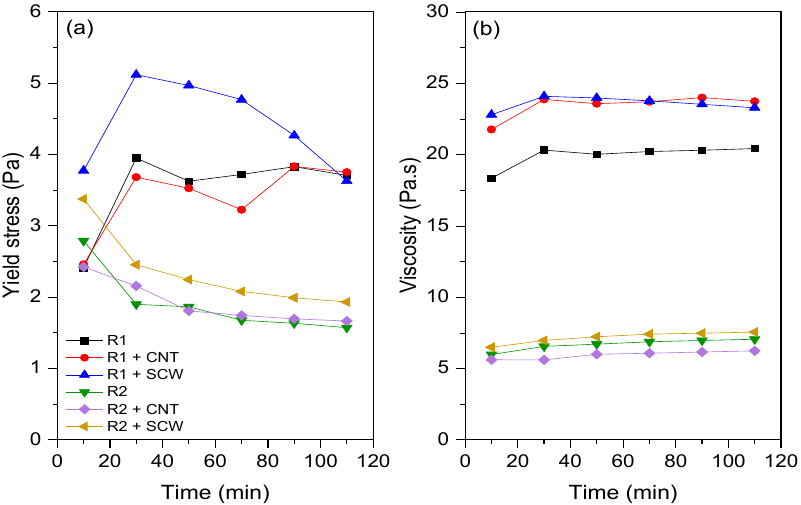
Figure 9. Rheological parameters by Casson model for all groups: ( a ) yield stress; ( b ) viscosity.